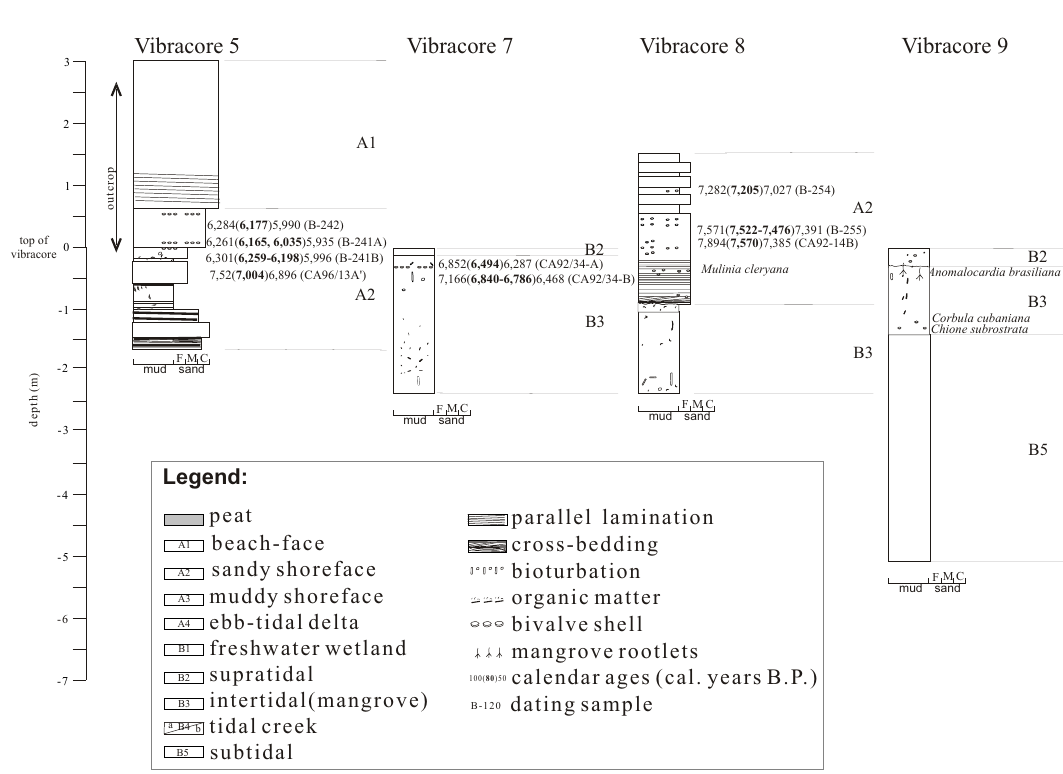
Fig. 7 – Sedimentary facies of vibracores 5, 7, 8 and